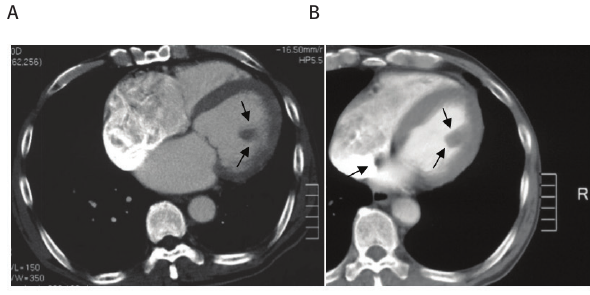
Figure 1: A: Chest CT findings after administration of rt-PA. B: Chest CT scans reveal multiple thrombi ( arrows ) in the left ventricle.